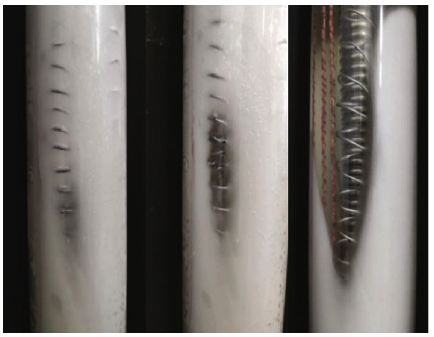
Figure 10: Para ffi n melting diagram near the spiral metal